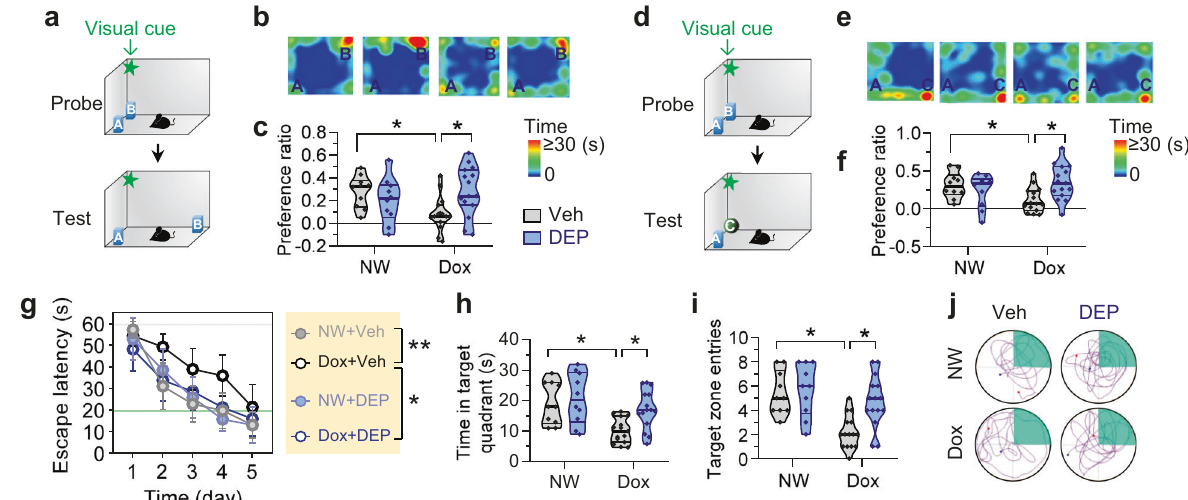
Fig. 6 DEPTAC improves hippocampus-dependent learning and memory in dox-treated Tau368 mice. a – f 1-month DEPTAC treatment after stopping the dox rescued the hTau-induced object-place ( a – c ) and novel-object ( d – f ) recognition impairments in Tau368 mice compared with the vehicle controls. Cartoons ( a , d ) show paradigms of the behavioral tests. Representative heatmaps ( b , e ) show the time-location of mice traveled in test chambers. Two-way ANOVA followed by Tukey ’ s multiple comparisons tests, * p < 0.05, n = 10 – 15 mice in each group. g DEPTAC signi fi cantly alleviated the hTau-induced spatial learning de fi cits in Morris water maze test. Repeated measures ANOVA followed by Tukey ’ s multiple comparisons tests, ** p < 0.01, * p < 0.05. h , i DEPTAC attenuated spatial memory de fi cits in dox-treated Tau368 mice shown by the increased time staying in h and number of entries into ( i ) the target quadrant in water maze test detected at day 6 after removed the platform. Two-way ANOVA followed by Tukey ’ s multiple comparisons, * p < 0.05. j Representative traces of the mice traveled in the water maze at day 6. Green areas indicate the target quadrants. Data were presented as